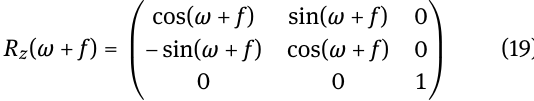
From Figure 10, The yaw, ψ , can be calculated